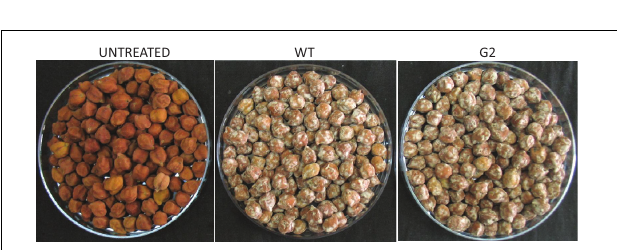
FIGURE 7 | Growth of Trichoderma virens wild type and mutant on tamarind seeds, 7 days after inoculation.